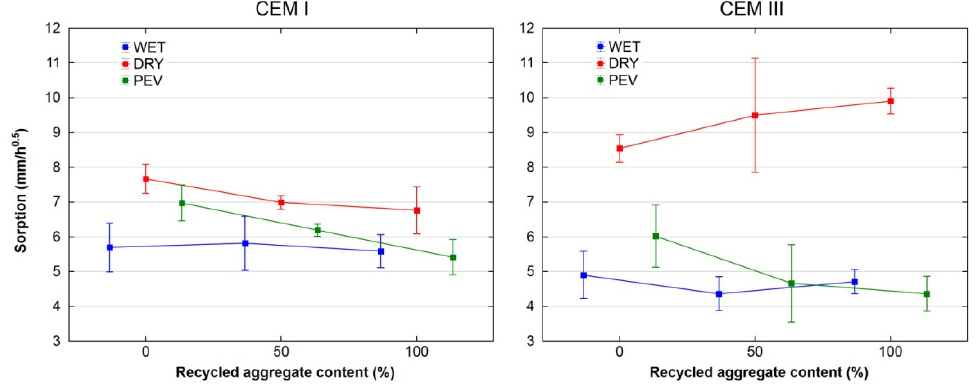
Figure 6. Sorption of concrete.